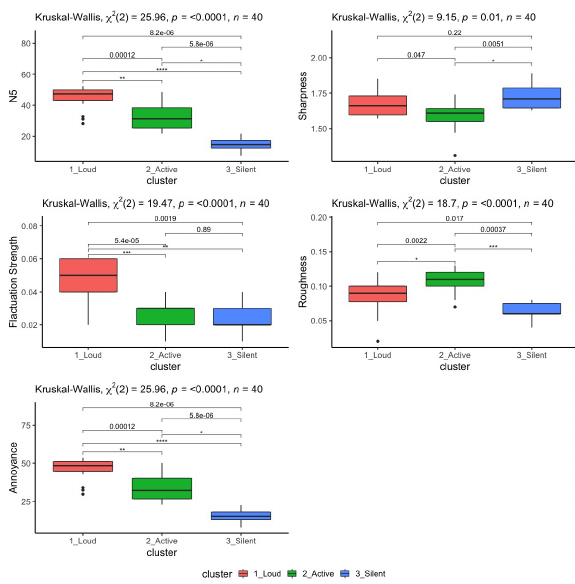
Figure 5: Variation in psychoacoustic parameters for three clusters.